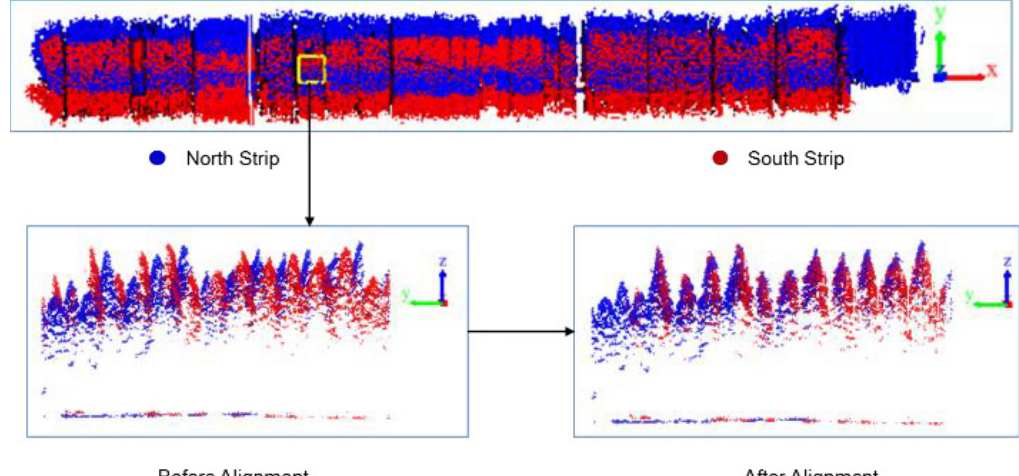
Figure 1. The planimetric discrepancy between two UAV